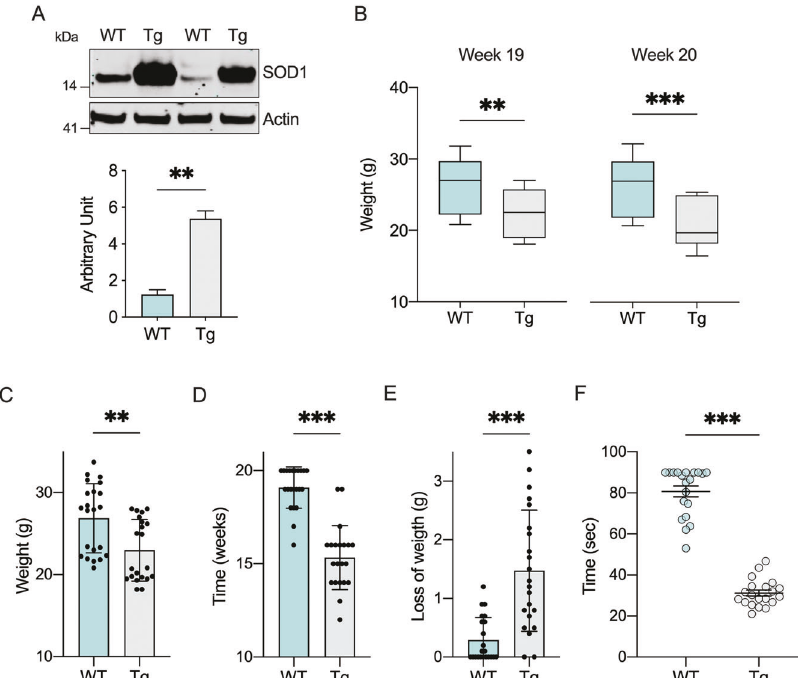
Fig. 1 SOD1 G93A overexpression correlates with weight loss and motor impairment onset in transgenic mice. A Representative Western blot of proteins extracted from spinal cord of wild type and transgenic mice and the relative quantitative analysis of SOD1. The loading control Actin was used for normalization. Data are expressed as mean ± SEM of n = 2 independent measurements. B Analysis of body weight related to weeks 19 and 20. Data are expressed as median ± SEM of n = 20 independent measurements. C – E Maximum weight reached C , age at the maximum weight D , and the weight loss at week 20 E relative to wild type and transgenic mice. Data are expressed as mean ± SD of n = 20 independent measurements. F Rotarod test performed on accelerating rod at week 20. Data are expressed as mean ± SEM of n = 20 independent measurements. All data were statistically analyzed by Student t-test, with ** p < 0.01 and *** p <